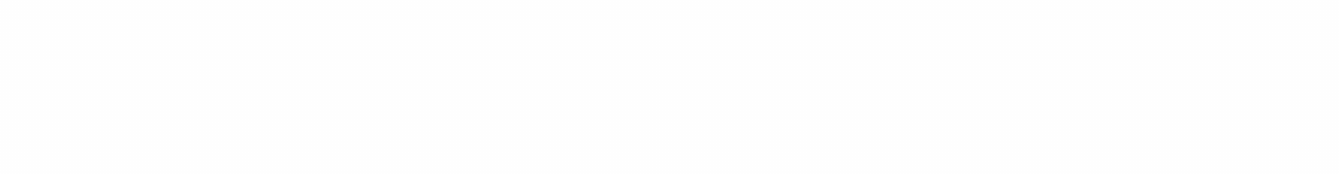
FIGURE 5 (a) Evolution of land use during 60 years. (b) Evolution of inhabitants and ewes during 60 years.